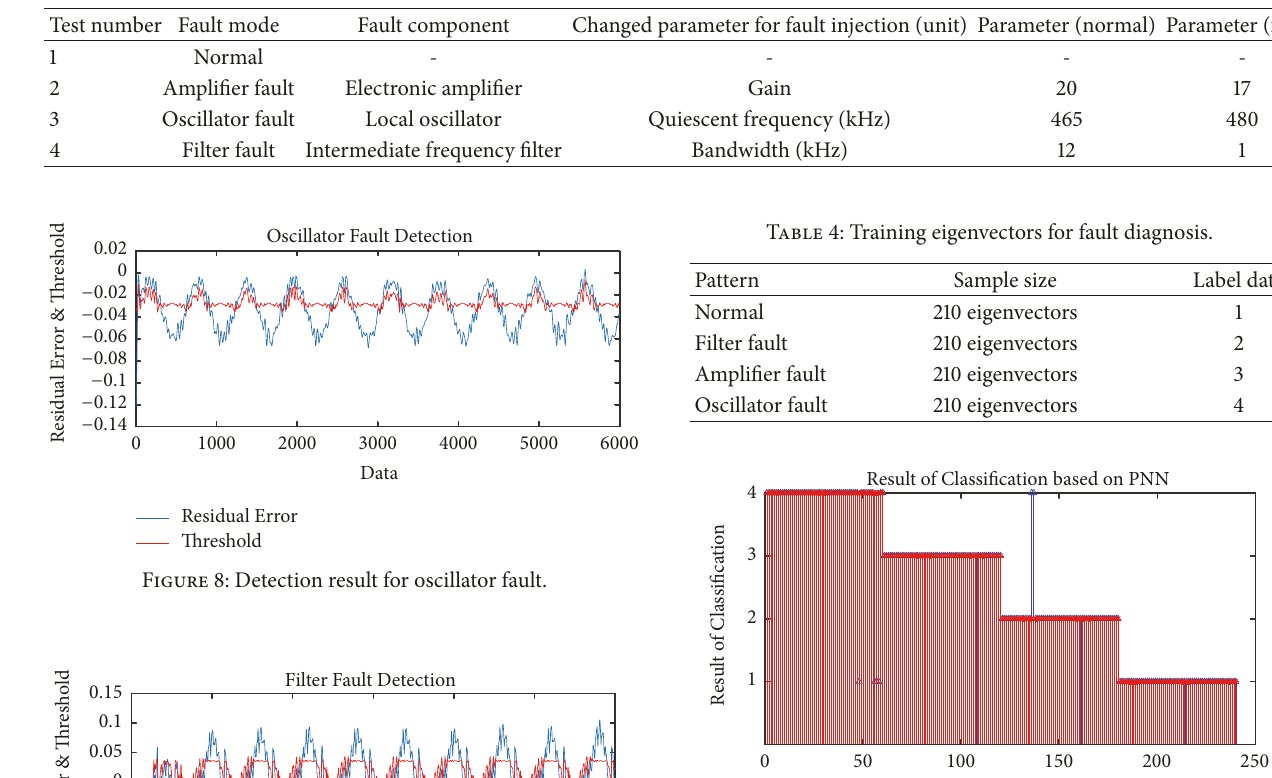
Table 3: Fault injection details.